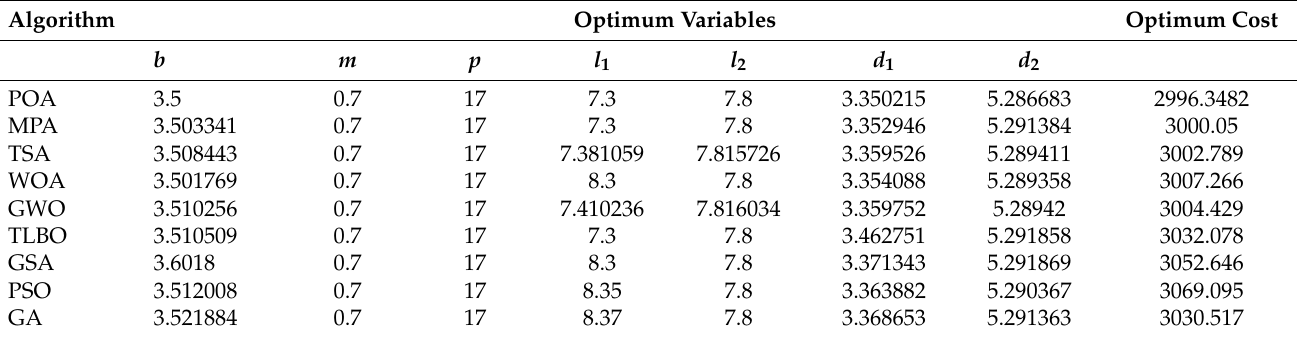
Table 11. Comparison results for speed reducer design problem.